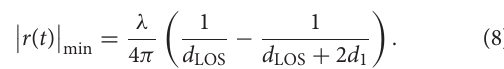
θ ( t ) = − 4 π f D t + π (mod 2 π ), we obtain completely